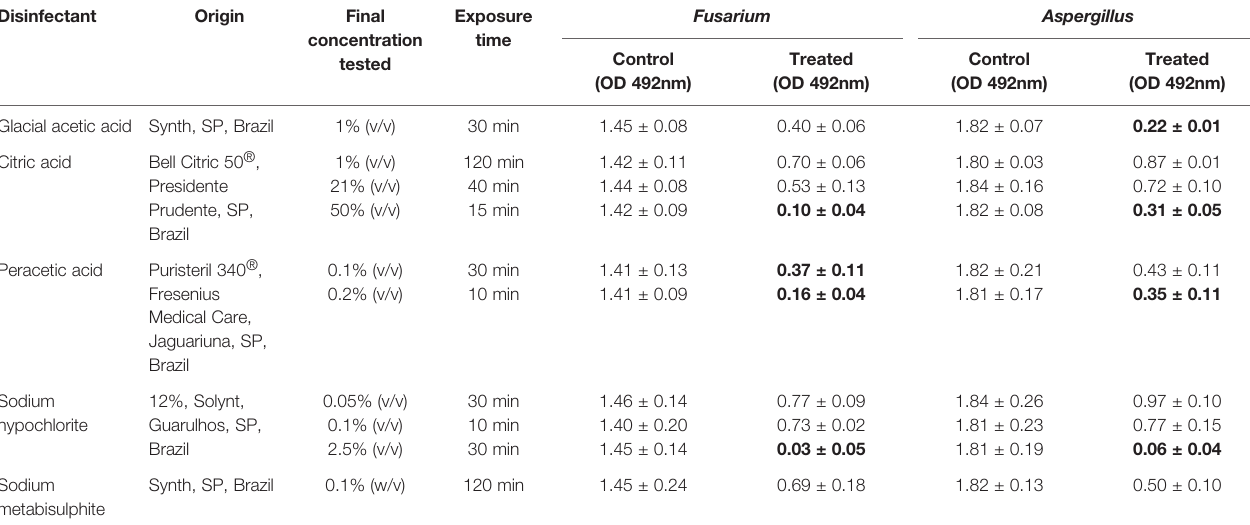
TABLE 5 | Disinfectants activities against Aspergillus and Fusarium bio fi lm cells. Disinfectant Origin Final